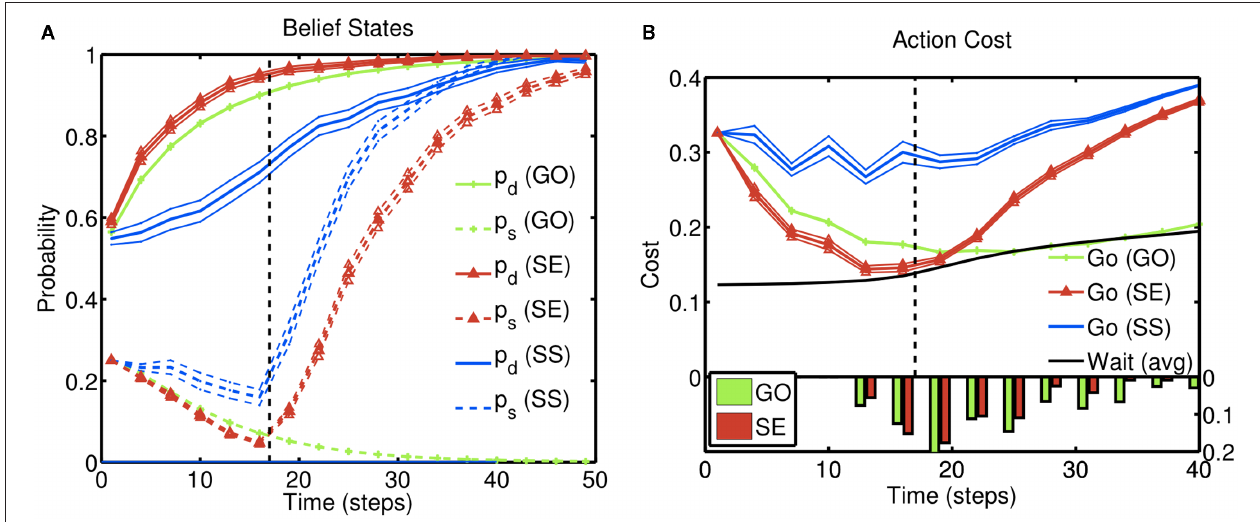
Figure 4 | inference and action selection in the stop signal task. (A) Evolution of the belief state over time, on go trials (green), successful stop trials (SS; blue), and error stop trials (SE; red). Solid lines represent the posterior probabilities assigned to the true identity of the go stimulus (one of two possibilities) for the three types of trials – they all rise steadily toward the value 1, as sensory evidence accumulates. The dashed black vertical line represents the onset of the stop signal on stop trials. The probability of a stop signal being present (dashed lines) rises initially in a manner dependent upon prior expectations of frequency and timing of the stop signal, and subsequently rises farther toward the value 1 (stop trials), or drops to 0 (go trials), based on sensory